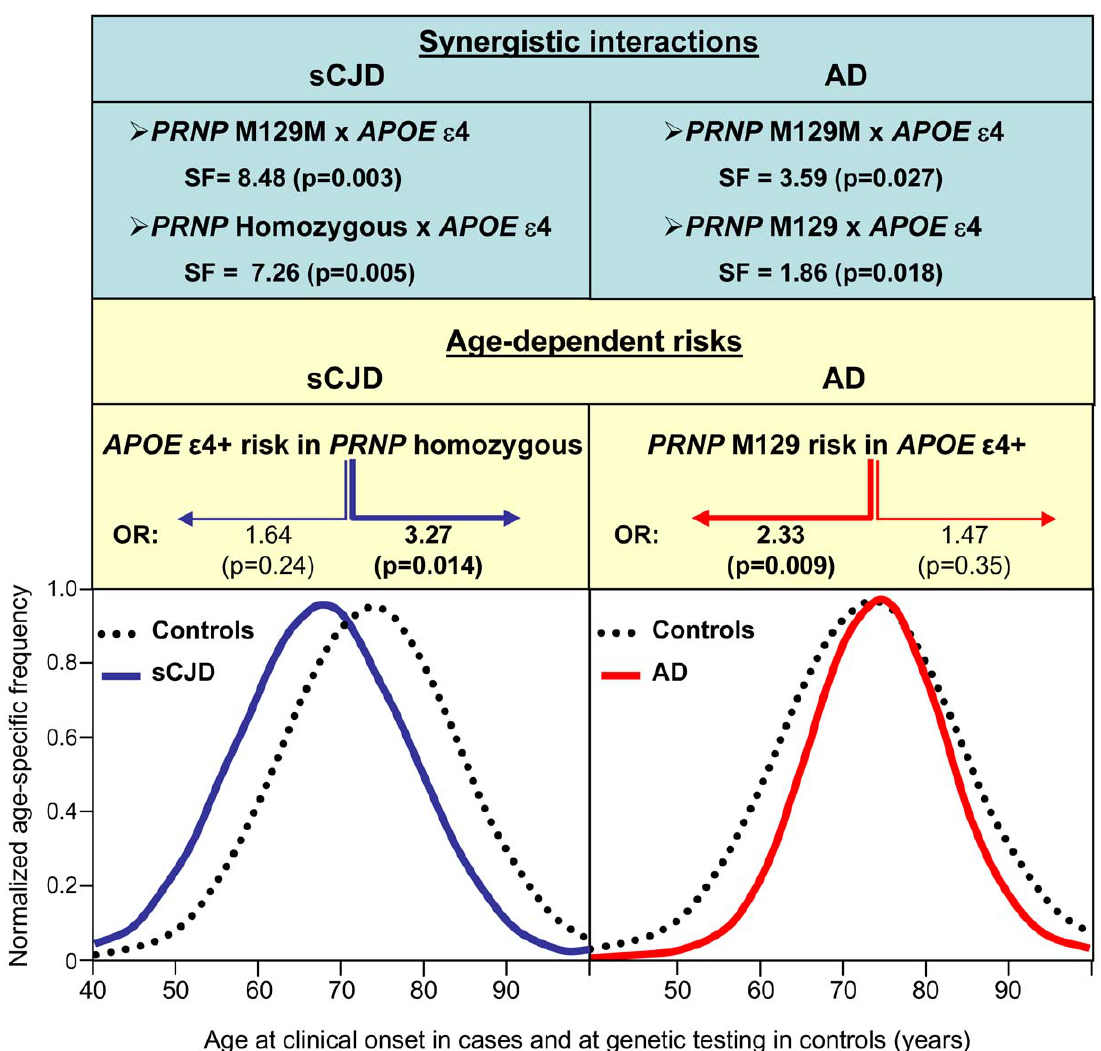
Figure 1. Synergistic age-dependent interaction between APOE and PRNP in both AD and sCJD. Top: Synergy factor values for the interaction PRNP codon 129 6 APOE e 4 in sCJD (left) and AD (right). Middle: Age-dependent risk. Left: sCJD associated with APOE e 4 allele in PRNP homozygous with onset before or after 71 years old. Right: AD associated with the PRNP M129 allele in APOE e 4 carriers with onset before or after 74 years old. Bottom: Normalized age-specific frequency at clinical onset for sCJD (left) and AD (right) and at genetic testing in controls adjusted to a normal distribution curve.